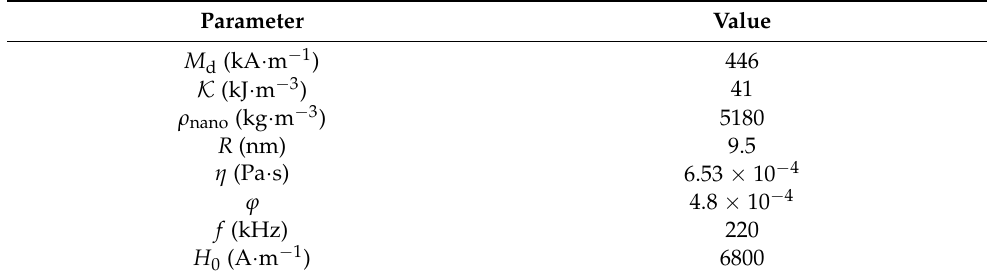
Table 4. Magnetic nanoparticles and magnetic field parameters [33,36,47,49,63].